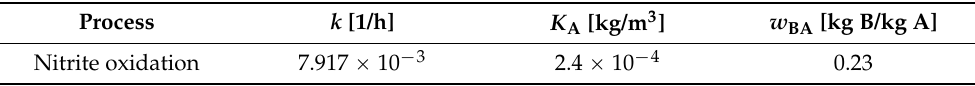
Table 1. Values of kinetic parameters for processes following Monod kinetic model